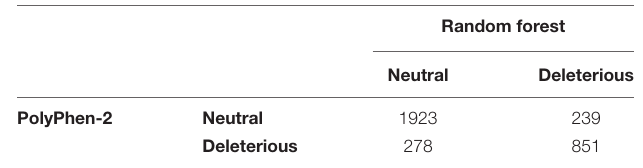
TABLE 3 | Comparison of the number of deleterious and neutral mutation predicted by PolyPhen-2 and Random Forest classifier in Cicer arietinum .